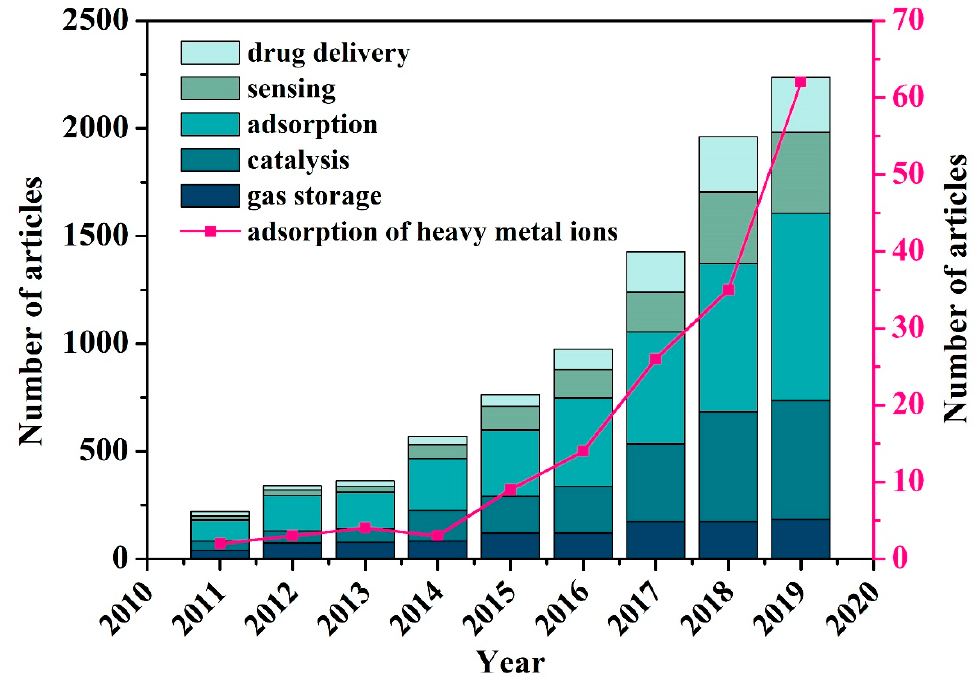
Figure 1. Number of articles retrieved in terms of the subjects “application of metal–organic frameworks in gas storage/catalysis/adsorption/sensing/drug delivery” and “adsorption of heavy metal ions by metal–organic frameworks”, from 2011 to 2019 on Web of Science.